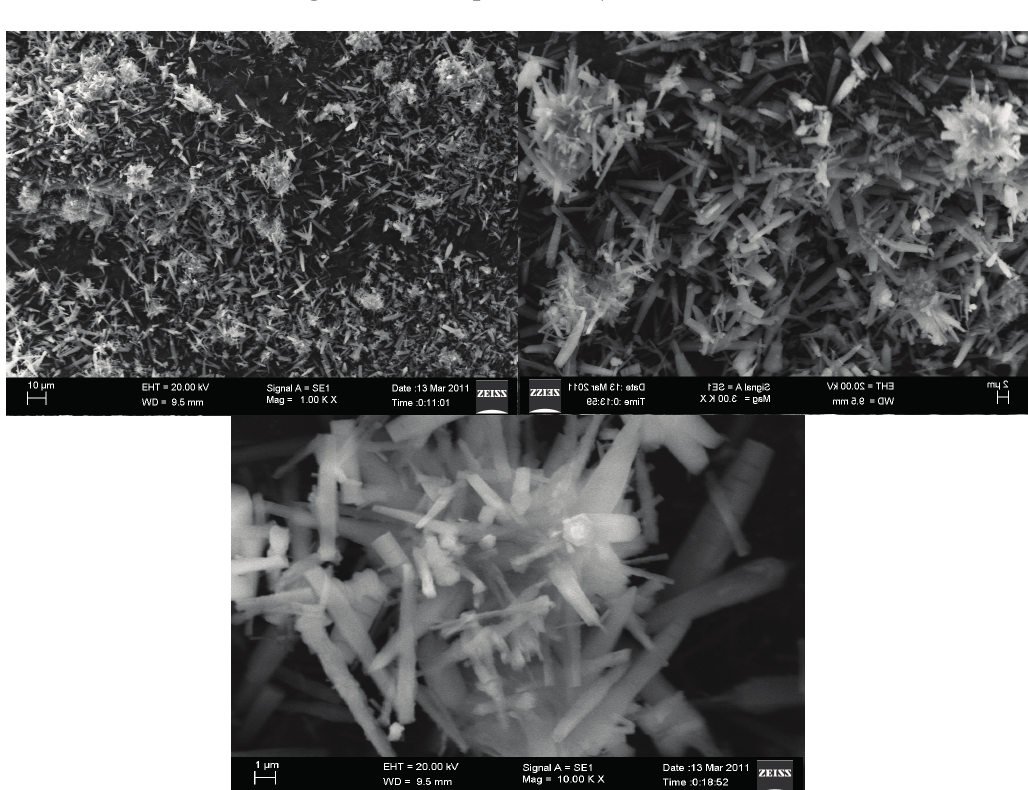
Figure 2. XRD pattern of γ -Al 2 O 3 NPs.